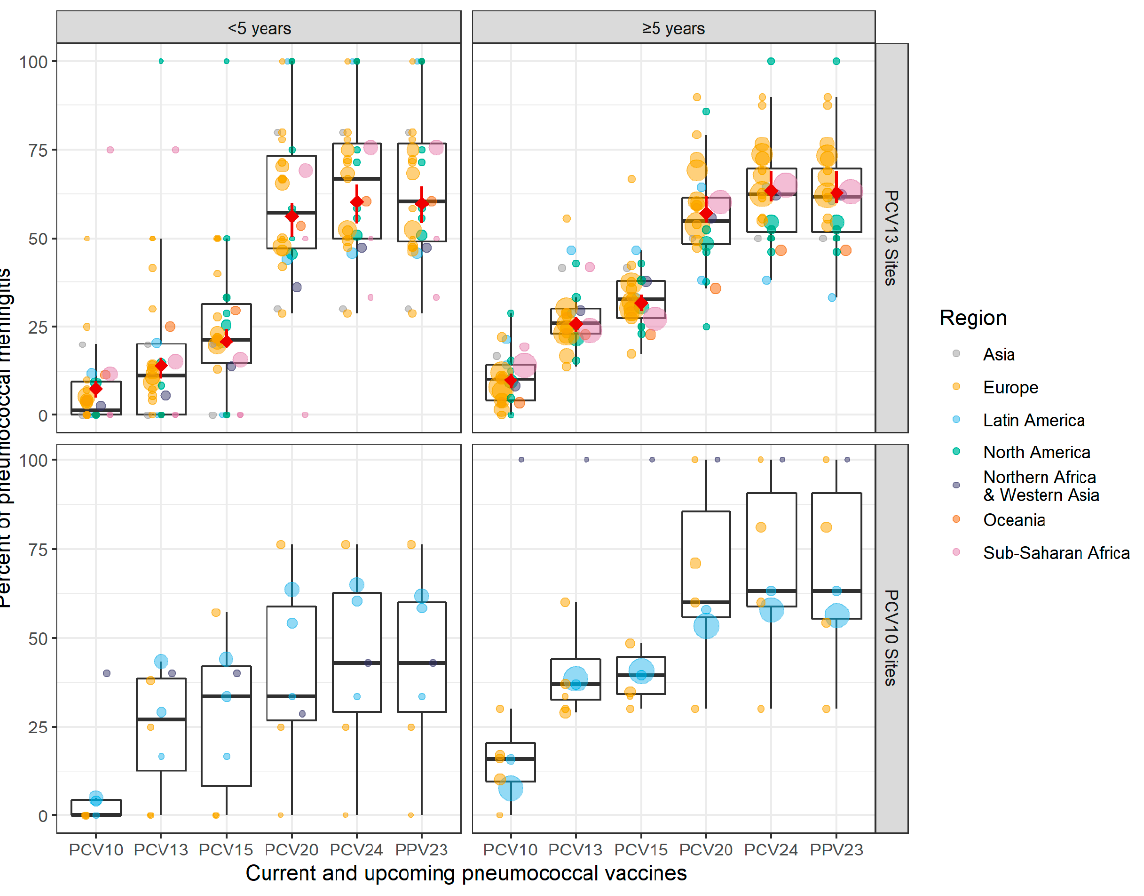
Figure 3. Site-specific percentages of CSF+ pneumococcal meningitis in the mature PCV10/13 period due to serotypes included in current and upcoming products. Each site is represented by a dot, which are colored by region and sized proportionally to the number of cases contributed by that site. The black boxes illustrate the IQR for the site-specific percentages. For PCV13 sites, the modeled results shown in Figure 2 are shown here in red diamonds. Data from Singapore are not shown for confidentiality but contributed to the PCV13 modeled results. PCV13 is Pfizer’s Prevnar13/Prevenar13; PCV10 is GSK’s Synflorix.